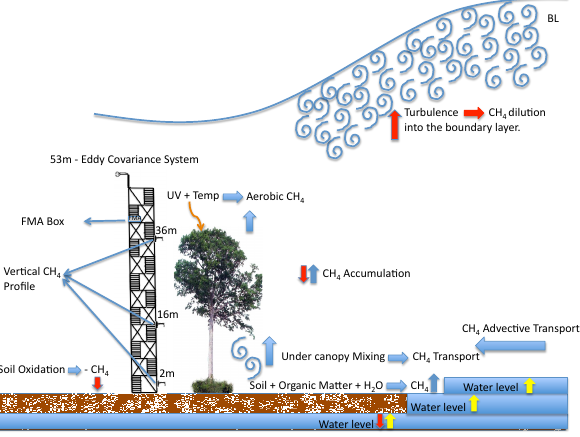
Fig. 1. Schematic picture of the measurement equipment installed at the K34 tower, in combination with processes that influence CH 4 levels below and above the canopy in the tropical forest environ- ment. 06:00h integrated samples are taken at levels, near the ground (2m), close to the top of the canopy (36m) and in the middle of the canopy (16m). The eddy flux equipment, including the inlet to the closed path FMA, is installed at 53m. CH 4 is formed via anaero- bic decomposition of the organic matter by methanogenic bacteria in the soil, which depends strongly on soil water level. Dynamical factors also should be considered. Under canopy mixing and advec- tion can transport CH 4 below the canopy. Since methane chemistry is rather slow, processes above the canopy is largely controlled by variations in the height of the planetary boundary layer, and by ad-